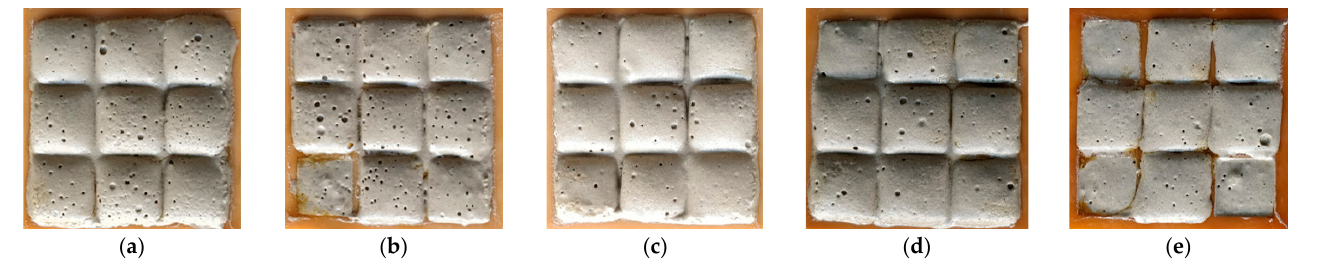
Figure 6. Initial foaming and expansion of the specimen mixture with different phosphogypsum addition: ( a ) P0, ( b ) P3, ( c ) P5, ( d ) P7, ( e ) P10.